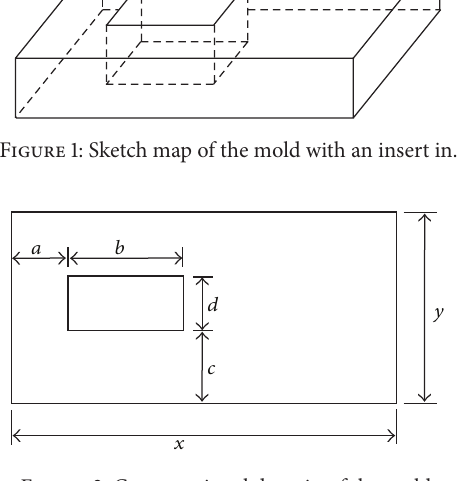
Figure 2: Computational domain of the